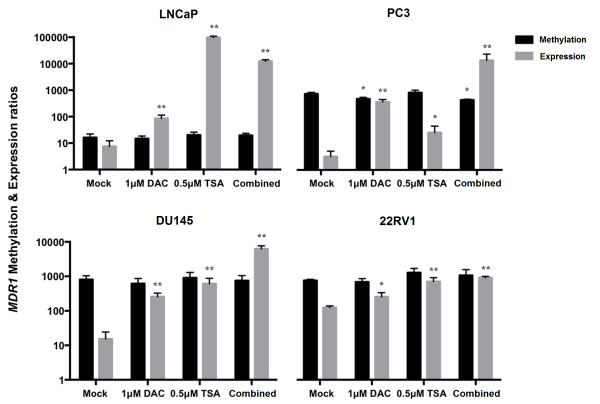
Methylation and expression levels of MDR1 in prostate cancer cell lines LNCaP, PC3, DU145 and 22RV1 in both untreated (Mock) and DAC or/and TSA treated cells. Asterisks represent statistically significant differences comparing to Mock, *p < 0.05; **p < 0.001. The represented scale is logarithmic.